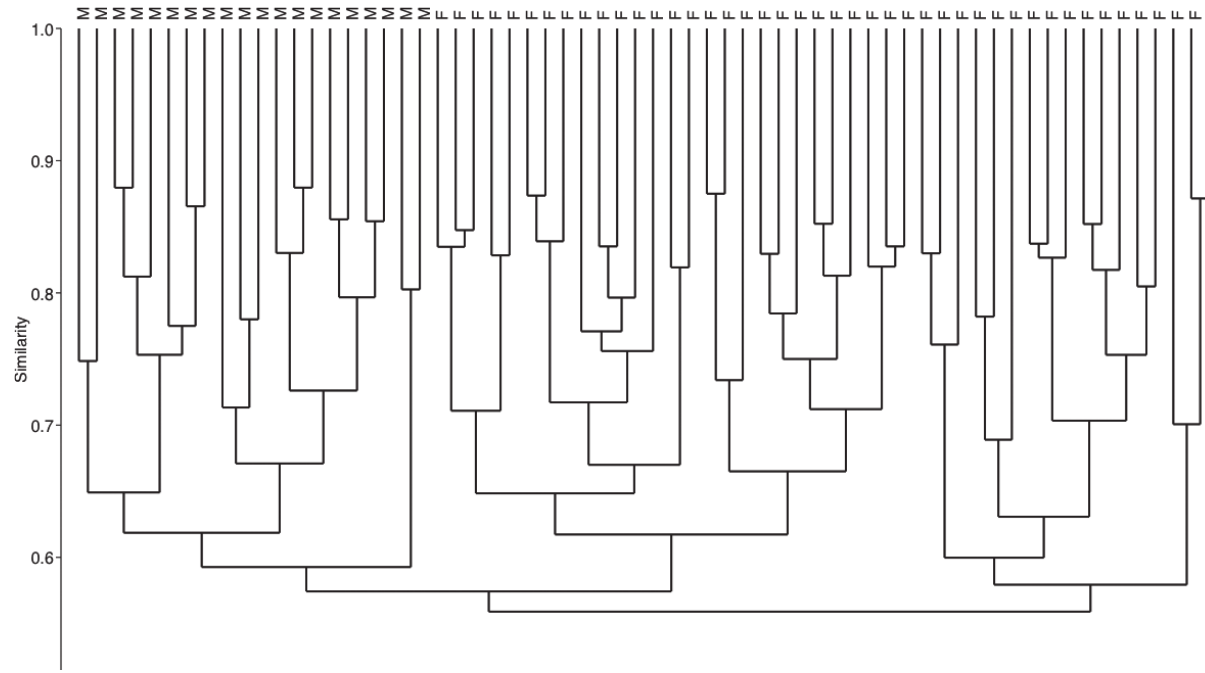
Figure 1. Ward dendrogram of male (M) and female (F) date palm trees based on combined molecular